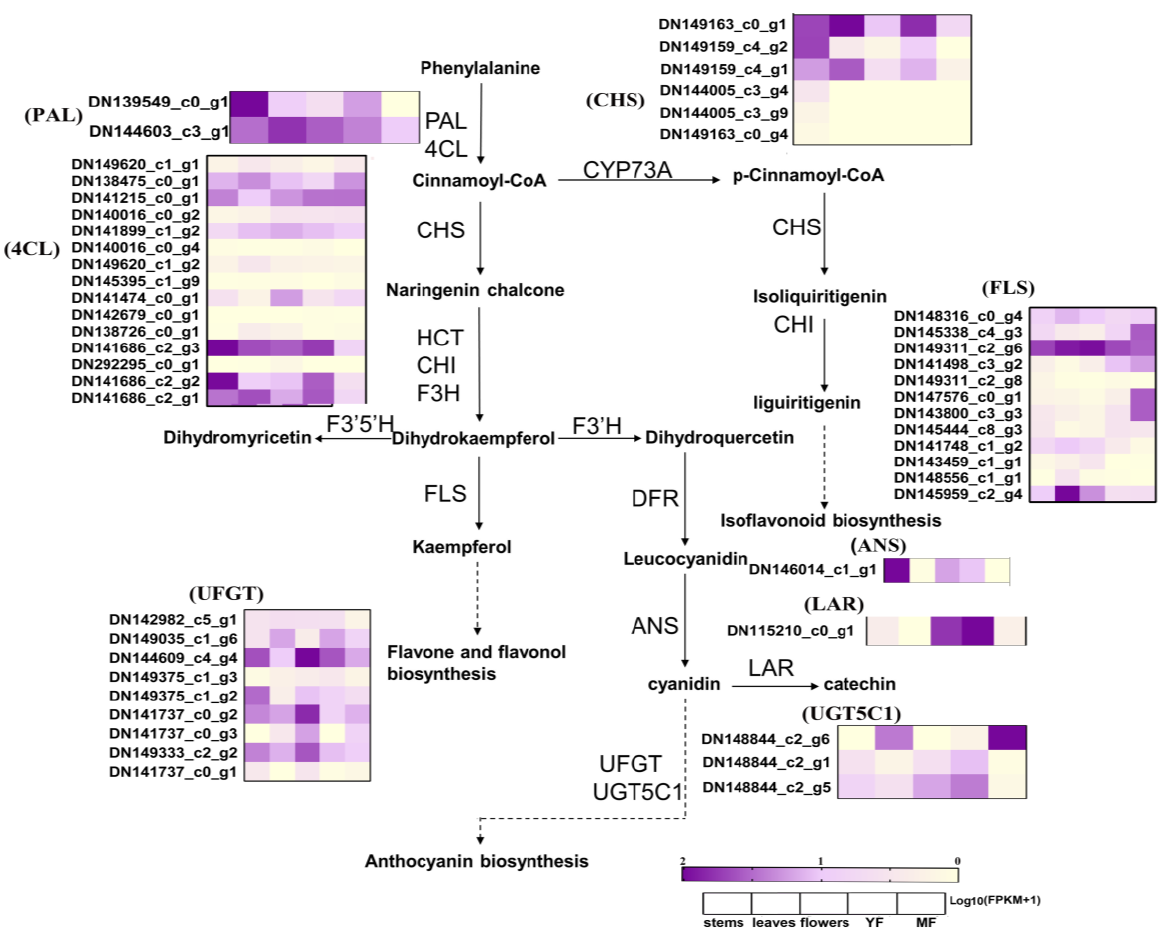
Figure 3. Simplified scheme and heatmaps of flavonoid biosynthesis pathway genes in R. roxburghii based on KEGG pathway. Abbreviation: PAL phenylalanine ammonia-lyase; 4CL, 4-coumarate-CoA ligase; CHS, chalcone synthase; CHI, chalcone isomerase; ANS, anthocyanidin synthase; FLS, flavanol synthase; DFR, dihydroflavonol-4-reductase; LAR, leucoanthocyanidin reductase; ANR, anthocyanidin reductase. UFGT, UDP-glucose flavonoid 3-O-glucosyltransferase; UGT75C1, anthocyanidin 3-O-glucoside 5-O-glucosyltransferase; YF, young fruits; MF, mature fruits. Arrows represent enzyme reactions; enzymes are shown next to the arrows. The color scale represents the log-transformed FPKM+1 value. Purple indicates high expression, and yellow indicates low expression.